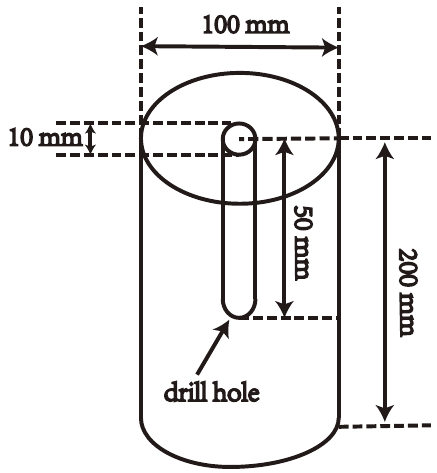
Figure 10. The dimensions of the sample.